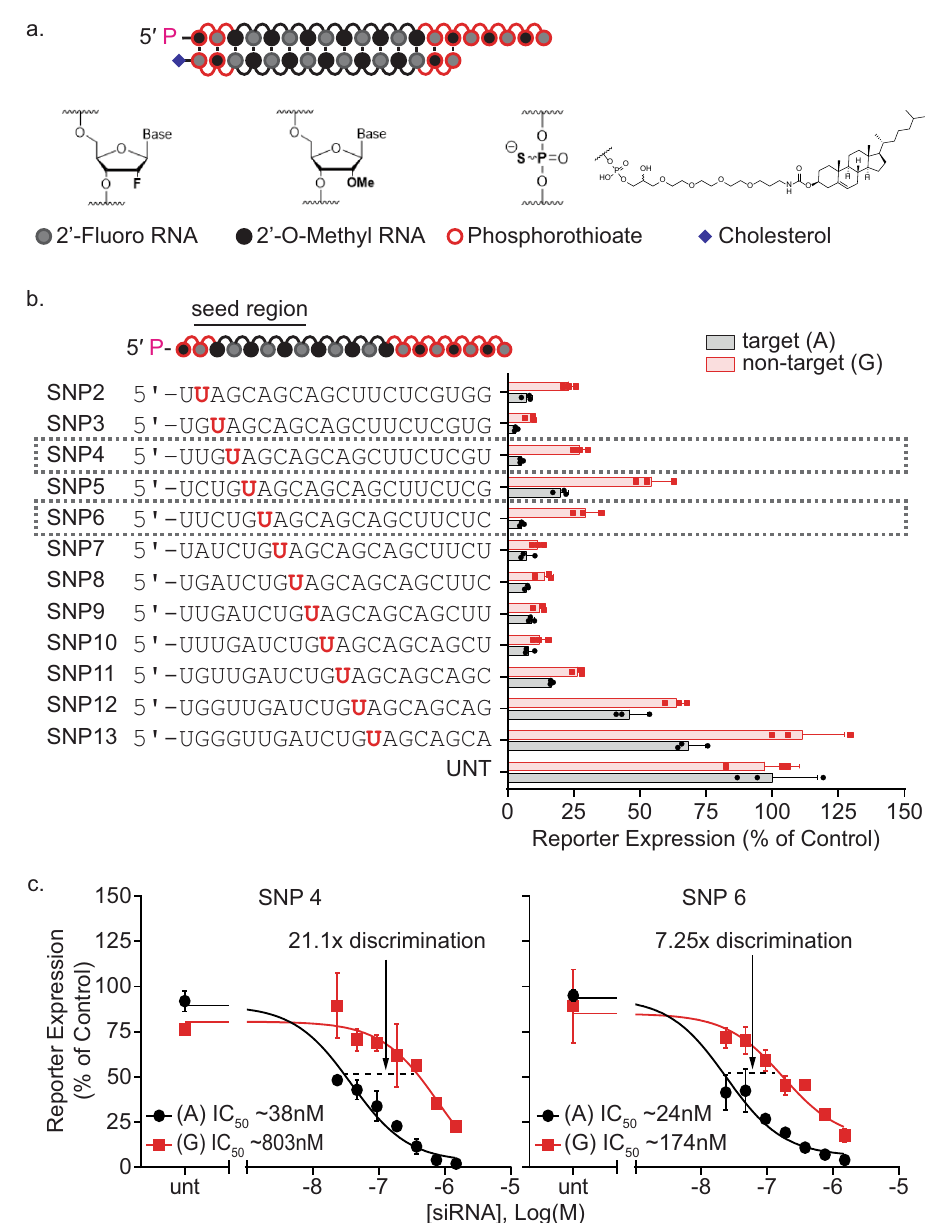
Fig. 1 | The primary screen for optimal siRNA sequence yields potent com- pounds with moderate discriminating power. a siRNA structure and chemical modi fi cation pattern used in screening. b The primary screen identi fi es the most favorable positions of the SNP enabling single nucleotide discrimination for tar- geting of SNP site rs362273 (highlighted in red). Compounds were tested using a dual-luciferase reporter assay system in HeLa cells. The (psiCheck) reporter plas- mids contain a 40mer region of huntingtin, including the target (A) SNP (black), and non-target (G) isoform (red). Cells were treated for 72h at 1.5 µ M of siRNA. A